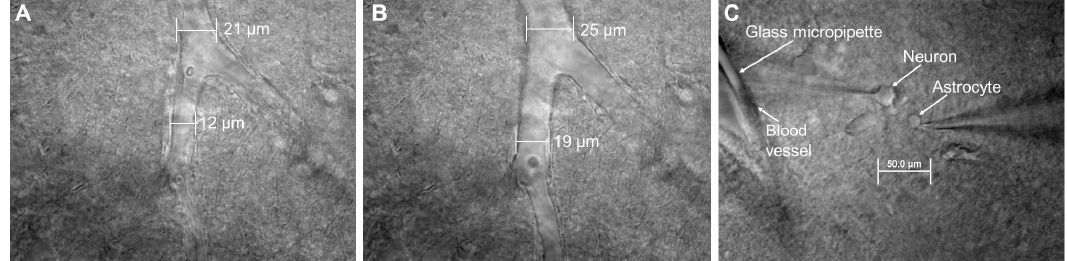
Figure 1. Perfusion of the blood vessel in a brain slice with artificial cerebrospinal fluid (ACSF). Photomicrograph of a blood vessel in the living brain slice under normal conditions ( A ) and when pressure is applied inside the vessel ( B ). ( C ) Blood vessel with microcapillary inserted inside and the neuron and astrocyte with attached microelectrodes. A glass electrode was inserted inside the blood vessel in a 400 μ m brain slice preparation, and 20–30 torr pressure (see text) was applied.